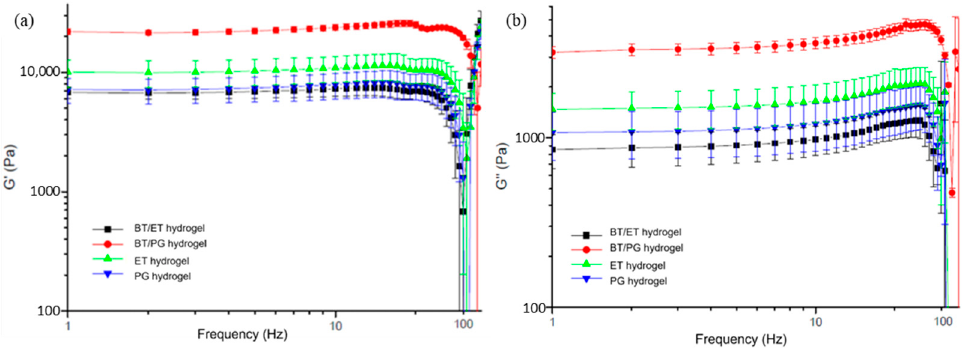
Figure 7. Rheological curve of ( a ) storage (G’) and ( b ) loss (G’’) modulus of the hydrogels.